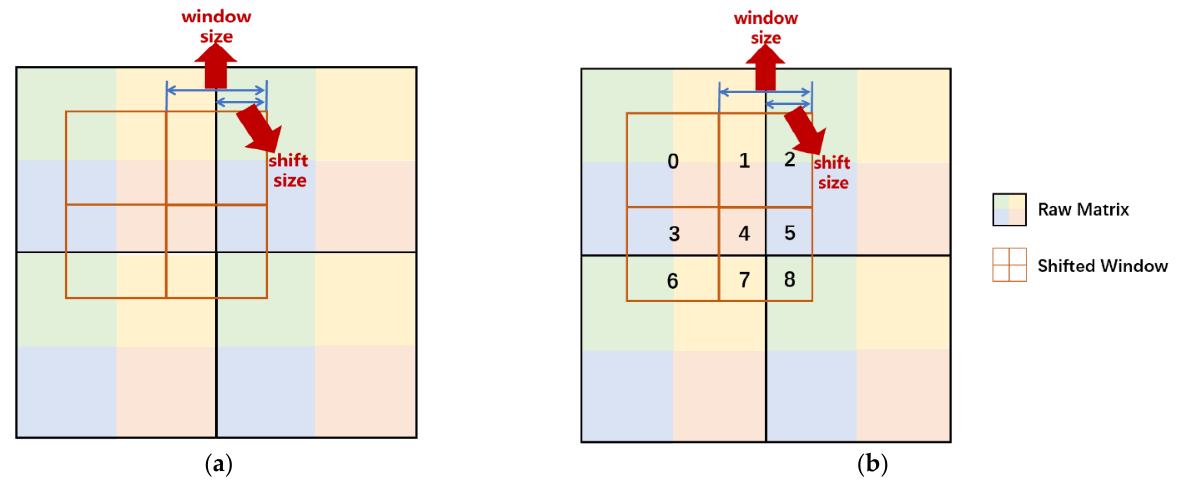
Figure 1. Mask slice and after mask slicing. ( a ) Mask slice; ( b ) After mask slicing.